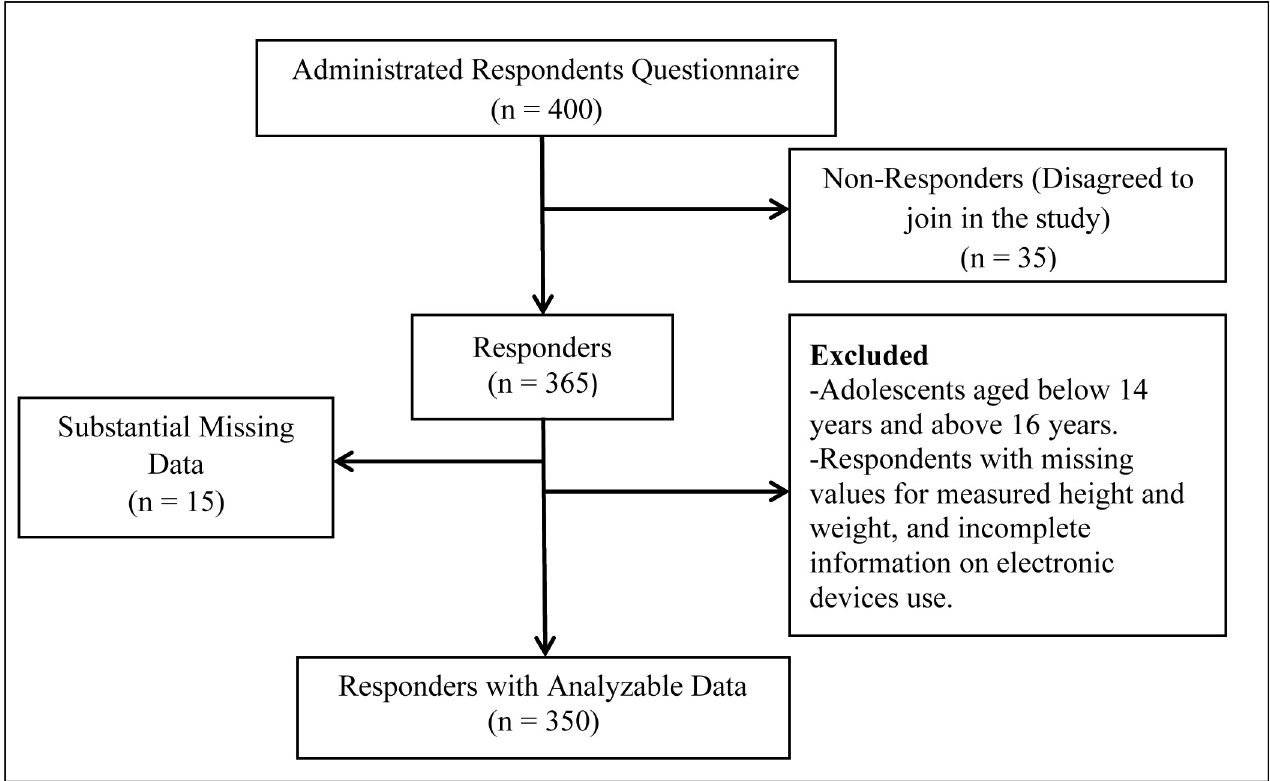
Fig 1. Flow chart of respondent’s recruitment.